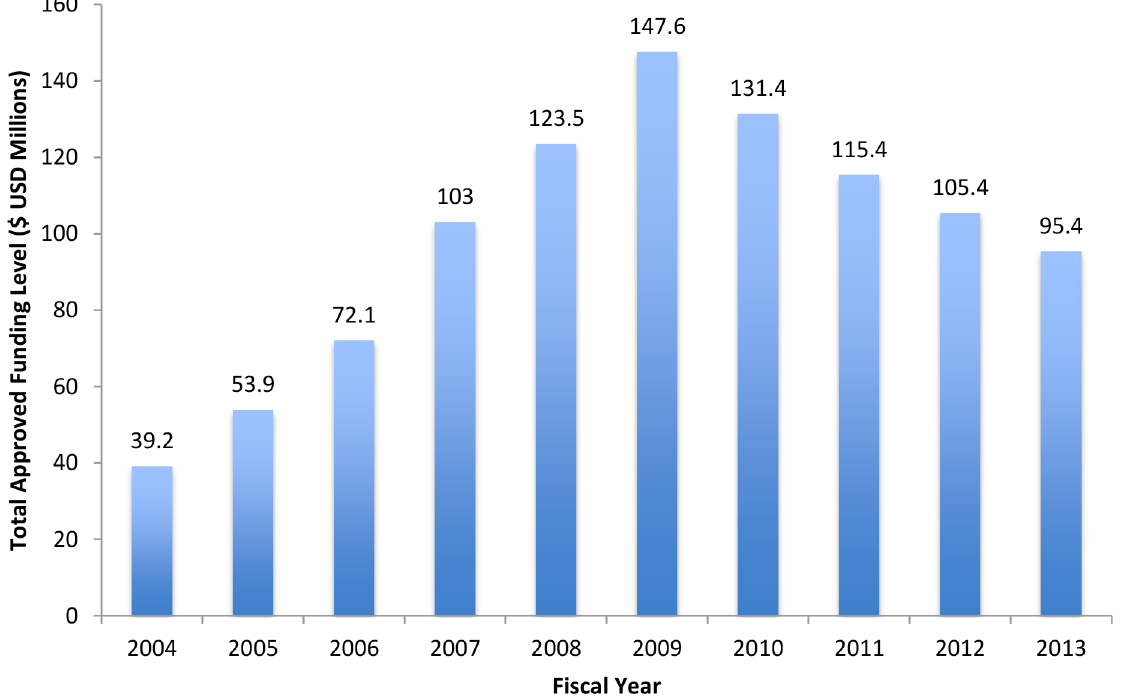
Fig 1. Total PEPFAR approved funding to Rwanda for HIV, tuberculosis (TB)/HIV, and health systems strengthening, 2004 – 2013. Sources: FY2004 – 2011: http://www.pepfar.gov/documents/organization/199598.pdf; 2012: http://www.pepfar.gov/ documents/organization/212155.pdf; 2013: http://www.pepfar.gov/documents/organization/222179.pdf. FY, Fiscal